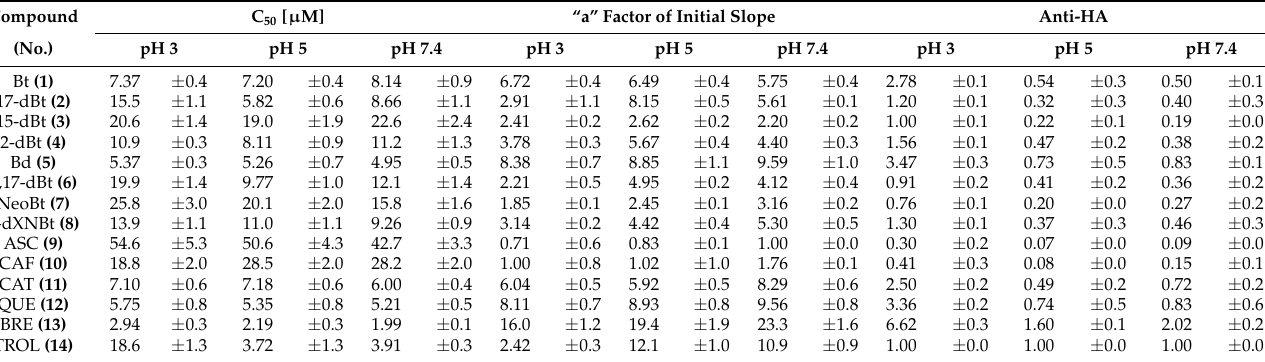
Table 3. Anti-hypochloric activity (Anti-HA) of betanidin ( Bd ), betanin ( Bt ), and its derivatives (17-decarboxy-betanin ( 17-dBt) , 15-decarboxy-betanin ( 15-dBt ), 2-decarboxy-betanin ( 2-dBt ), betanidin ( Bd ), 2,17-decarboxy-betanin ( 2,17-dBt ), neobetanin ( NeoBt ), and 2-decarboxy-xanneobetanin ( 2-dXNBt )) and selected antioxidants (ascorbic acid ( ASC ), caffeic acid ( CAF ), catechin ( CAT ) and quercetin ( QUE )) related to Trolox ( TROL ) based on measurements of initial slope “a” factors for fluorescence intensity-compound concentration dependence at selected pH. C50—concentration of the measured anti-hypochloric agent required for a 50% decrease in the fluorescence emission of the 150 mM HCSe probe after 5 min of its incubation with reaction mixture of 150 mM NaOCl and the anti-hypochloric agent at 25 ◦ C. The measurements were performed in